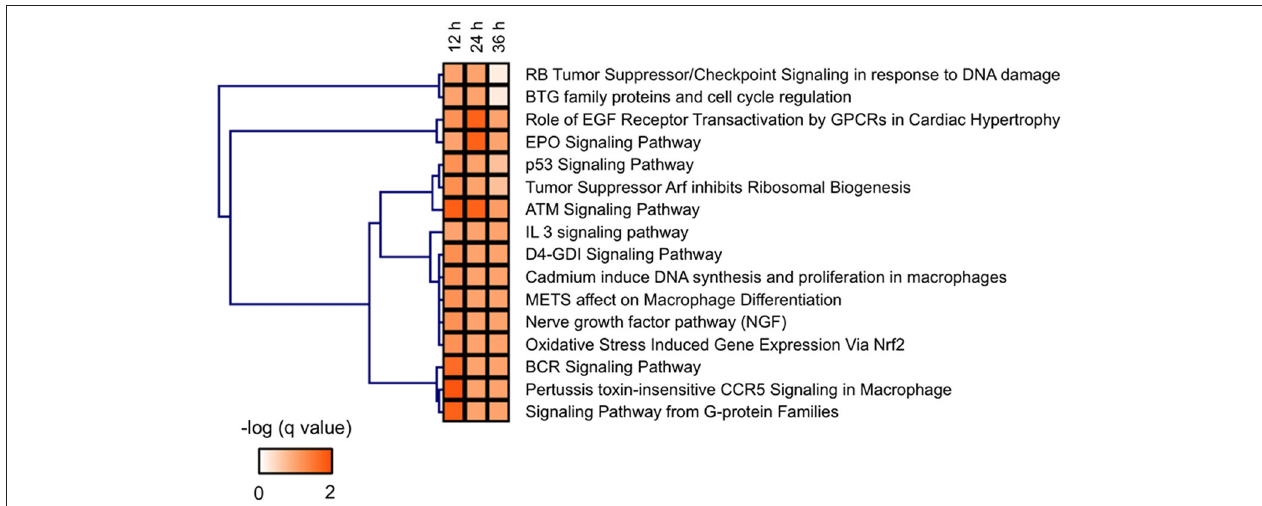
FIGURE 4 | BioCarta pathways significantly related to the genes dysregulated in zebrafish exposed to MBZ. Genes dysregulated in zebrafish exposed to 0.3 µ M MBZ for 12, 24, and 36h were independently subjected to JEPETTO using BioCarta as the database. The BioCarta pathways significantly related to the dysregulated genes at each time points were subjected to hierarchical clustering using the q-value for